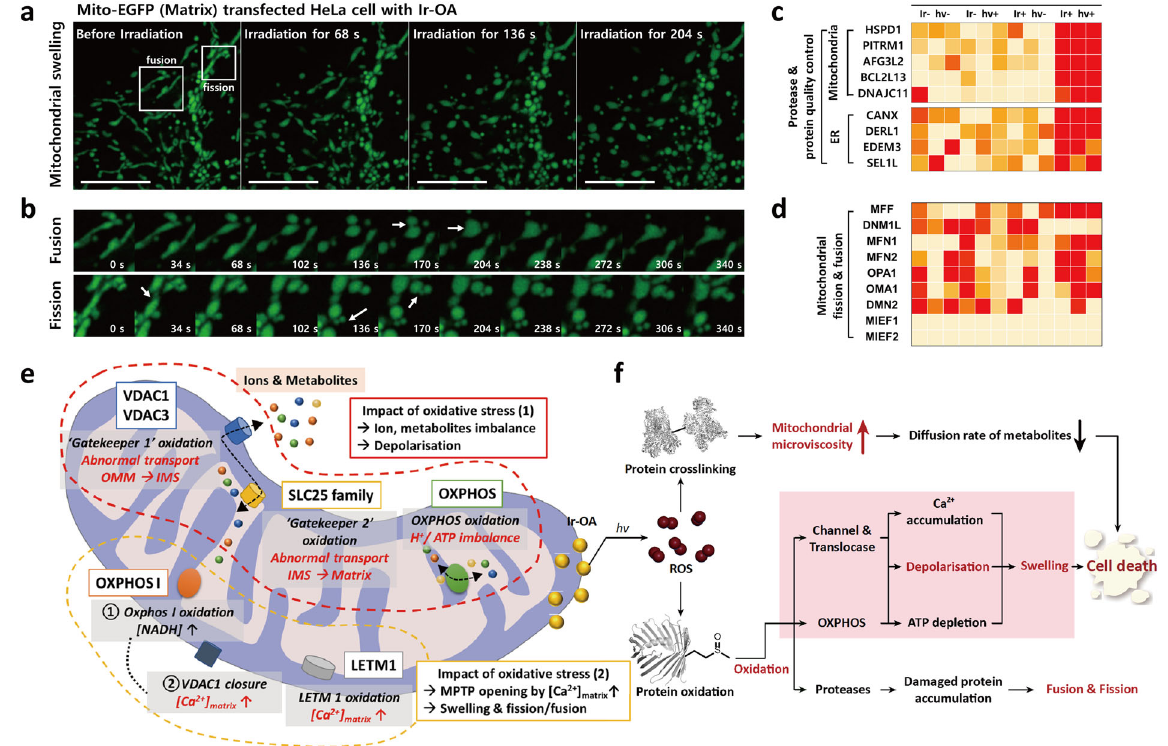
Fig. 7 Mitochondria morphology monitoring and proposed cell death mechanism. a Time-lapse Airyscan 2 images of HeLa cells with Ir-OA before light irradiation (14 mW, 405 nm laser of laser scanning microscopy) (left) and after irradiation for 204 s (right). To monitor morphological changes, the mitochondrial matrix was transfected by Mito-EGFP (green signal) (scale bars = 10 μ m). White boxes indicate mitochondrial fi ssion and fusion. The from Fig. 7a. Along with fi ssion and fusion, mitochondria swelling was also observed. c Investigation of proteases and mitochondrial fi ssion and